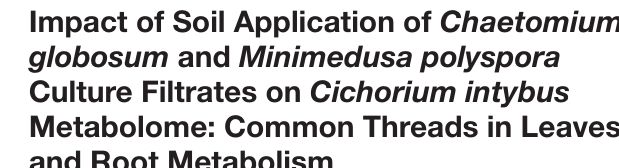
juncea (mustard), Solanum lycopersicum (tomato),